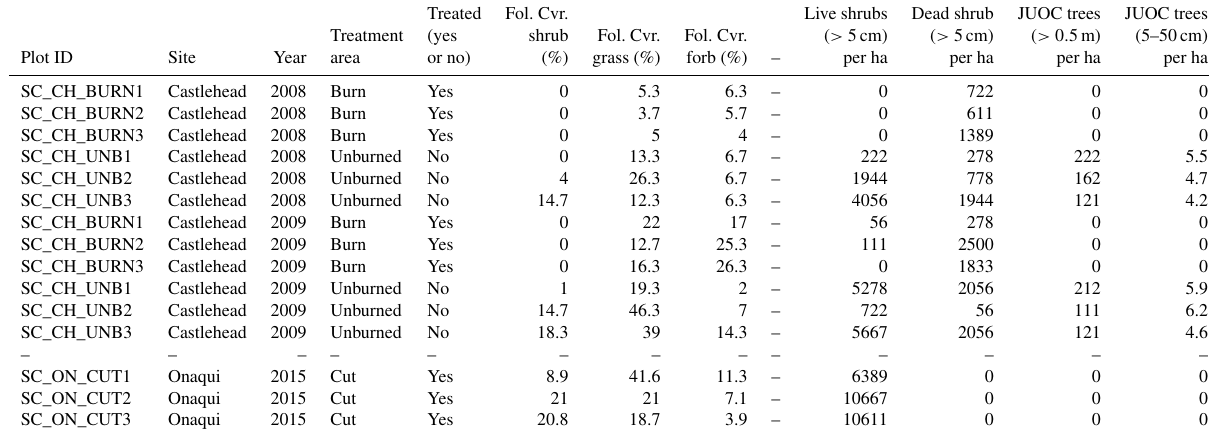
Table 5. Example (subset) of vegetation and ground cover variables and data structure for measures on hillslope-scale site characterization plots (990m 2 ) at the study sites. Abbreviations in the table example are as follows: Fol. Cvr. refers to foliar cover, and JUOC refers to western juniper ( Juniperus occidentalis